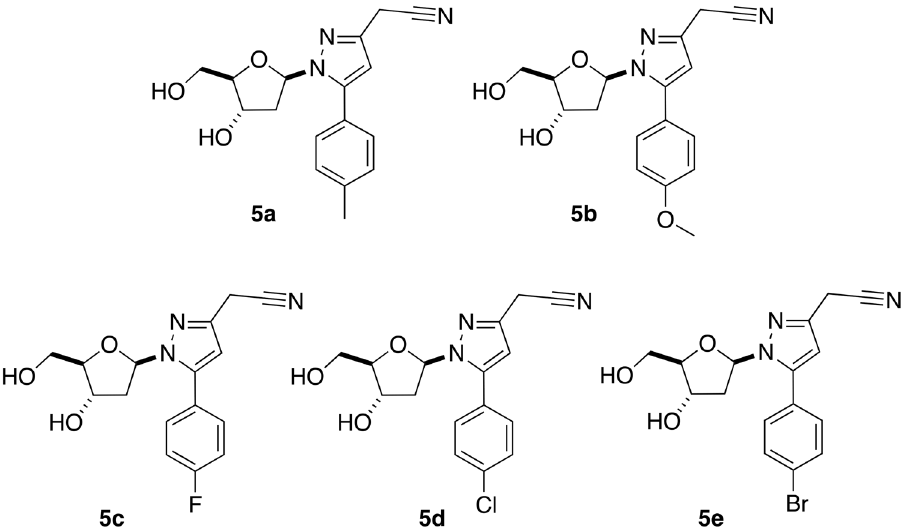
Figure 1. Structures of the pyrazolylnucleosides 5a – e